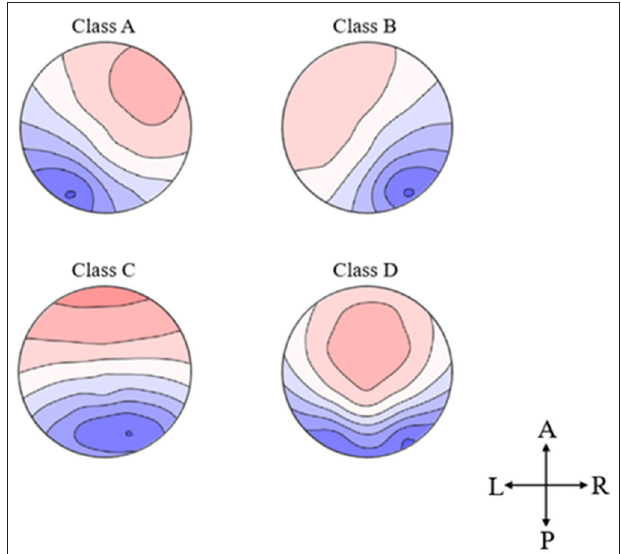
FIGURE 1 | Topographical microstate maps. The figure shows the resulting four microstates, which are labeled according to previous literature. The different colors signify the different polarities. The maps are represented as seen from above (A, Anterior; P, Posterior; L, Left; R,